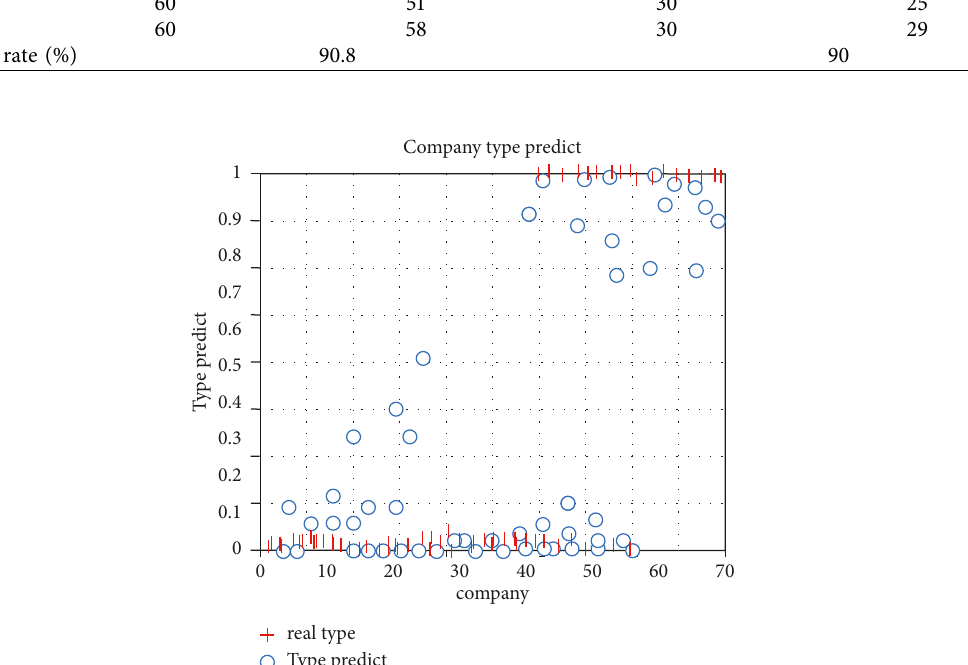
Figure 3: Probability distribution of financial distress of listed real estate companies under the neural network model.